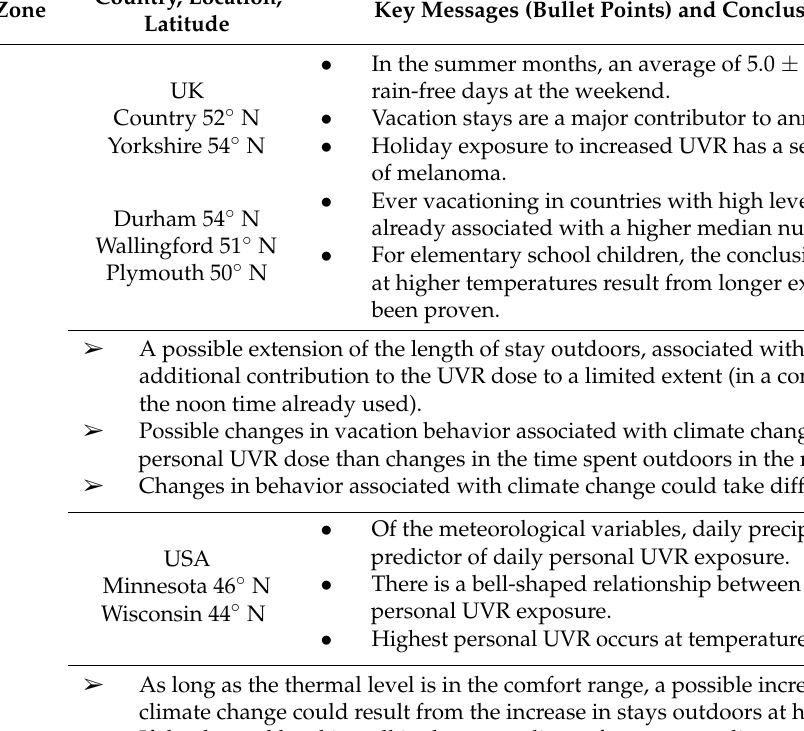
Key Messages (Bullet Points) and Conclusions (Bullet